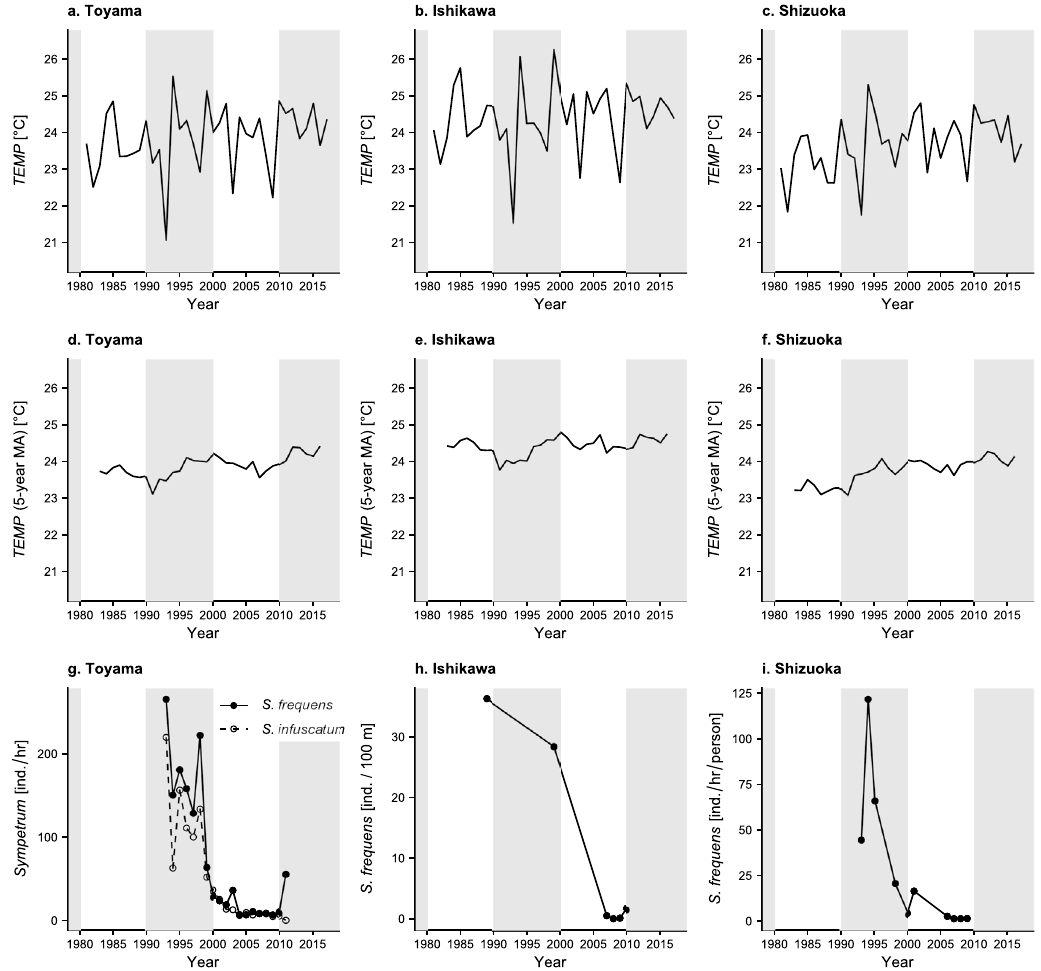
Figure 1. Changes in ( a – c ) the annual 90th percentile values of daily mean temperature during July–August ( TEMP ) and ( d – f ) their 5-year moving averages (MA), and ( g – i ) abundances of Sympetrum dragonflies in the three prefectures. Dragonfly data come from Futahashi (2012) for Toyama, Uéda (2012) for Ishikawa, and Fukui (2012) for